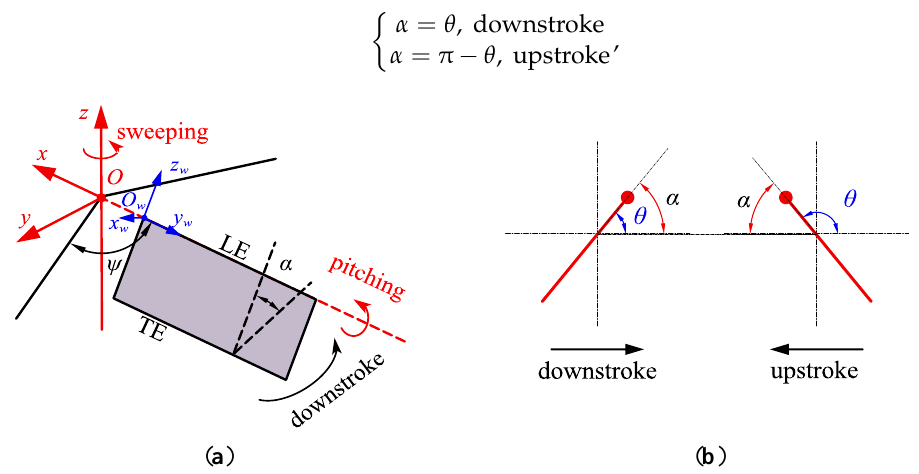
Figure 2. Definition of the flapping angle variables. ( a ) Schematic diagram of the sweeping and pitching motion and coordinate systems. ( b ) Definition of the angle of attack α and rotation angle θ . The red dot means the leading edge. The black arrow line represents the flapping